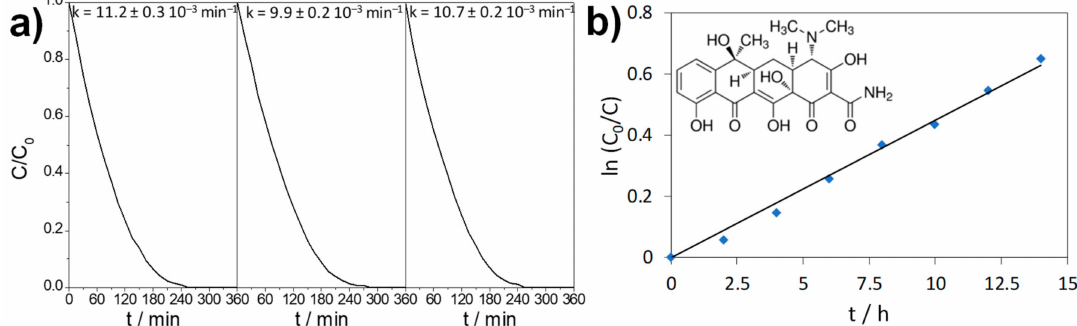
Figure 5. Photocatalytic tests results: ( a ) ethanol disappearance under UV irradiation and the relative rate constant in the recycle tests; ( b ) Determination of the rate constant of tetracycline disappearance in simulated solar photocatalytic tests: logarithmic conversion plot as a function of irradiation time (R 2 =